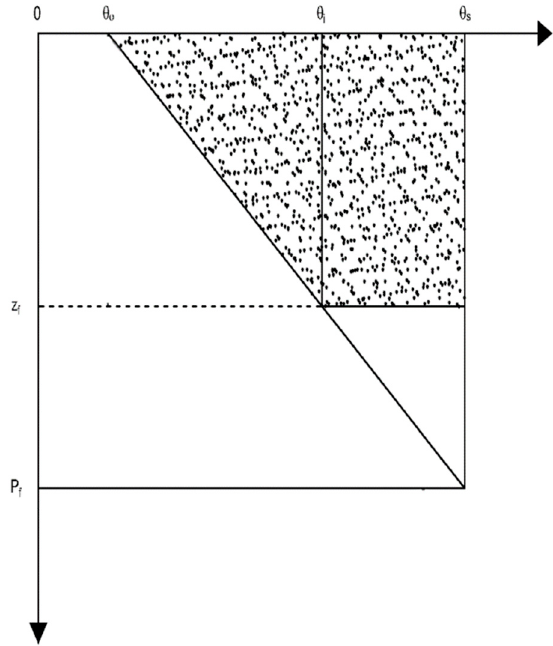
Figure 2. Soil moisture profile with a shallow water table.